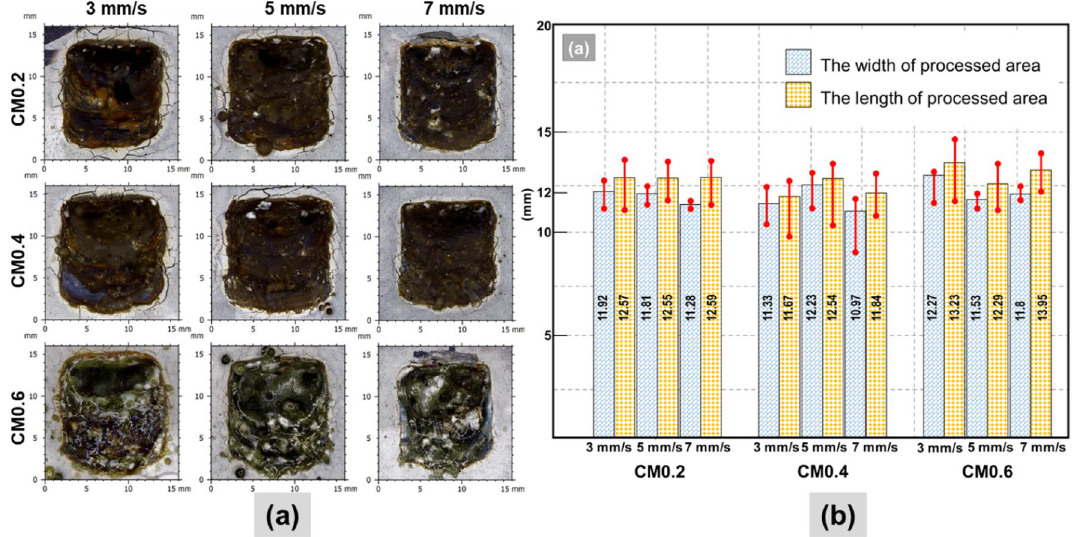
Figure 2. ( a ) Surface observation of CM series samples; ( b ) Dimension of CM series samples by using the confocal